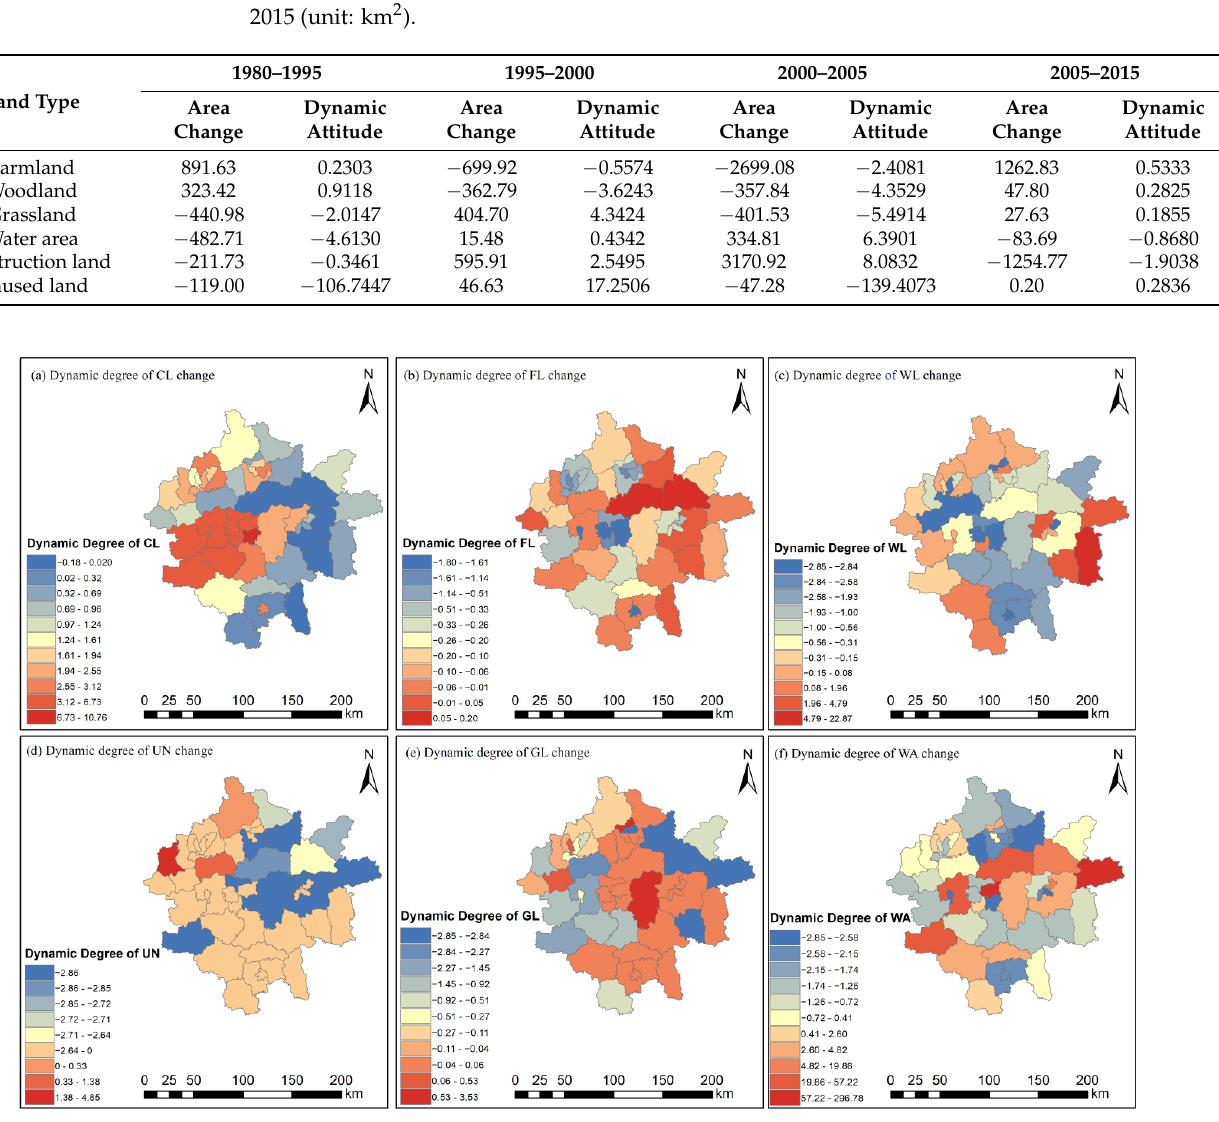
Figure 6. Spatial distribution of dynamic land use attitudes of ( a ) construction land (CL), ( b ) farmland (FL), ( c ) woodland (WL), ( d ) unused land (UN), ( e ) grassland (GL), and ( f ) water area (WA).